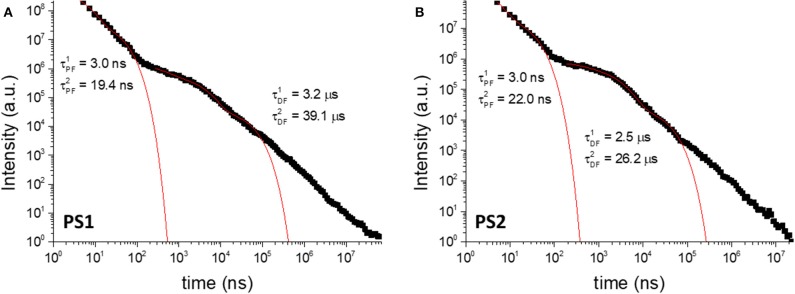
Luminescence decays of PS1 (A) and PS2 (B) collected in degassed aqueous suspension at room-temperature. λex = 355 nm.